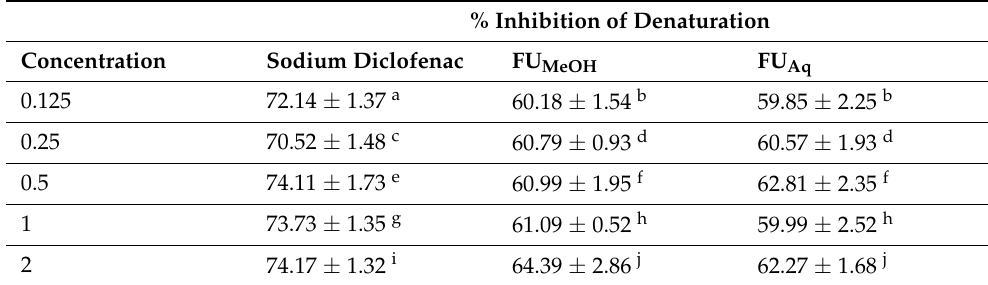
Table 6. Inhibitory effects of sodium diclofenac and F. umbellatta extracts on albumin denaturation.